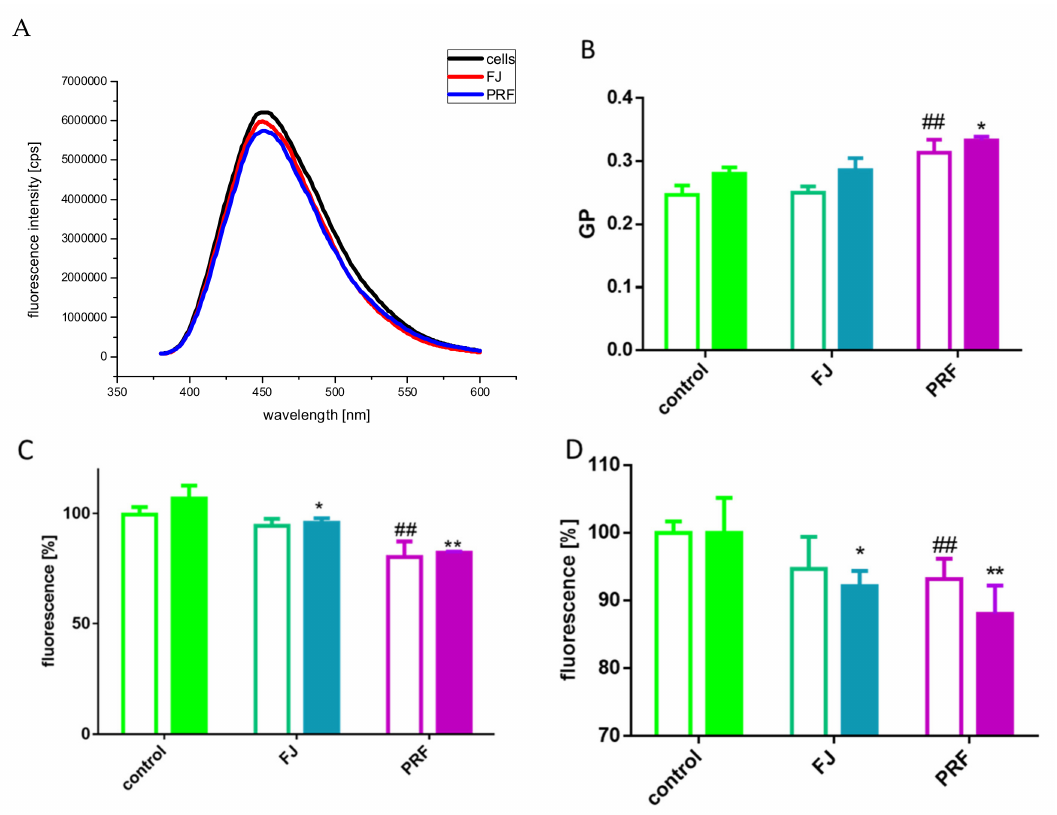
Figure 10. The emission spectra of Laurdan-labeled cells before and after incubation with V. opulus extracts at IC 0 dosages ( A ). Changes in cell membrane fluidity expressed as values of GP for Laurdan probe after cells incubation with extracts in low (open bars) or high (closed bars) glucose conditions ( B ). The influence of extracts on intracellular ROS generation analyzed by DCFH-DA assay in low (open bars) or high (closed bars) glucose conditions ( C ). Hyperpolarizing e ff ect induced by extracts on cellular membrane in low (open bars) or high (closed bars) glucose conditions ( D ). Control cells were not exposed to any compound but the vehicle; values are means ± standard deviations from at least three independent experiments, n ≥ 12; statistical significance was calculated versus control cells treated with low glucose * p ≤ 0.05, ** p ≤ 0.01 or high glucose ## p ≤